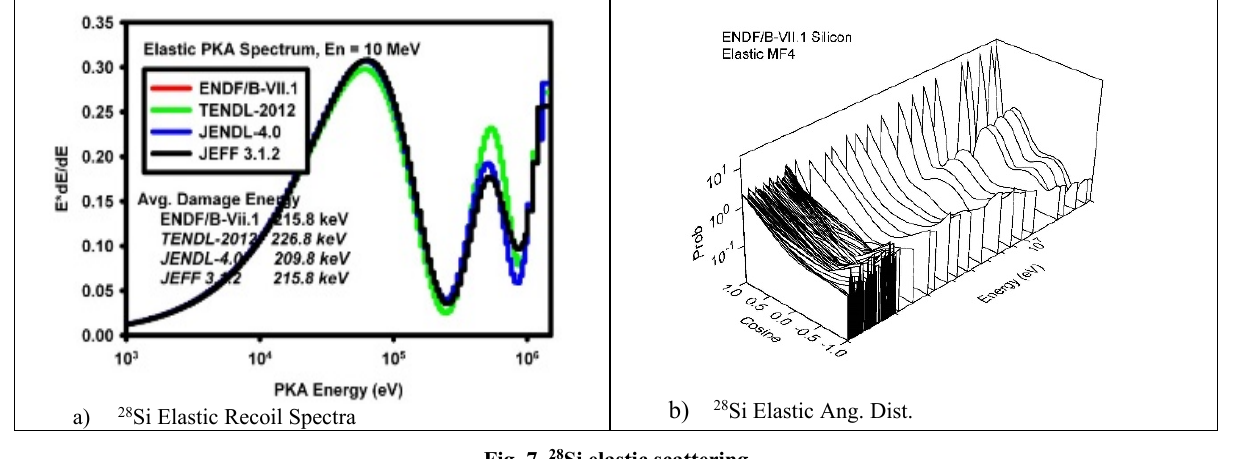
Fig. 7. 28 Si elastic scattering